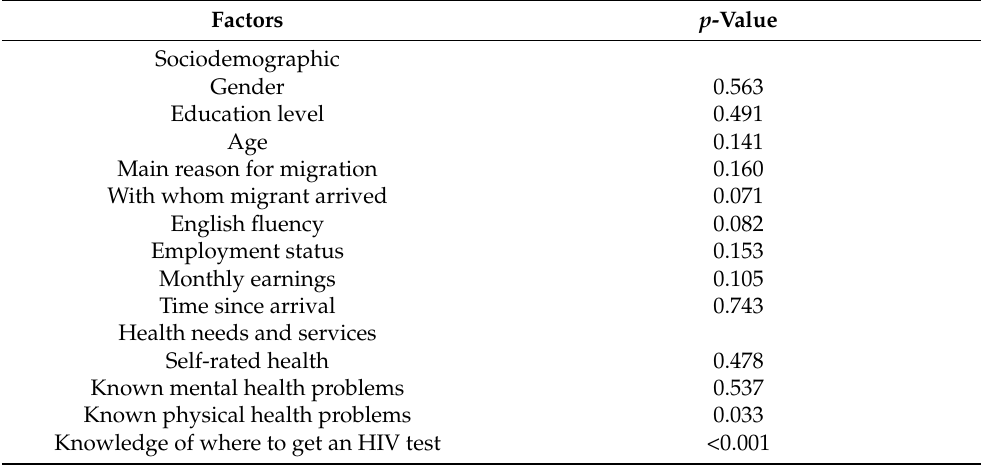
Table 3. Factors associated with having received an HIV test while in